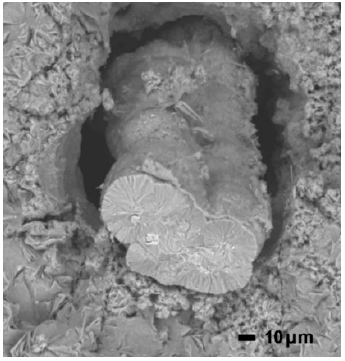
Figure 18. Morphology of the innermost SFF (JAL-SM-01) formed by connected spheres with a common surface; the negative contour is visible on the surrounding clay minerals, interrupted by a free space.